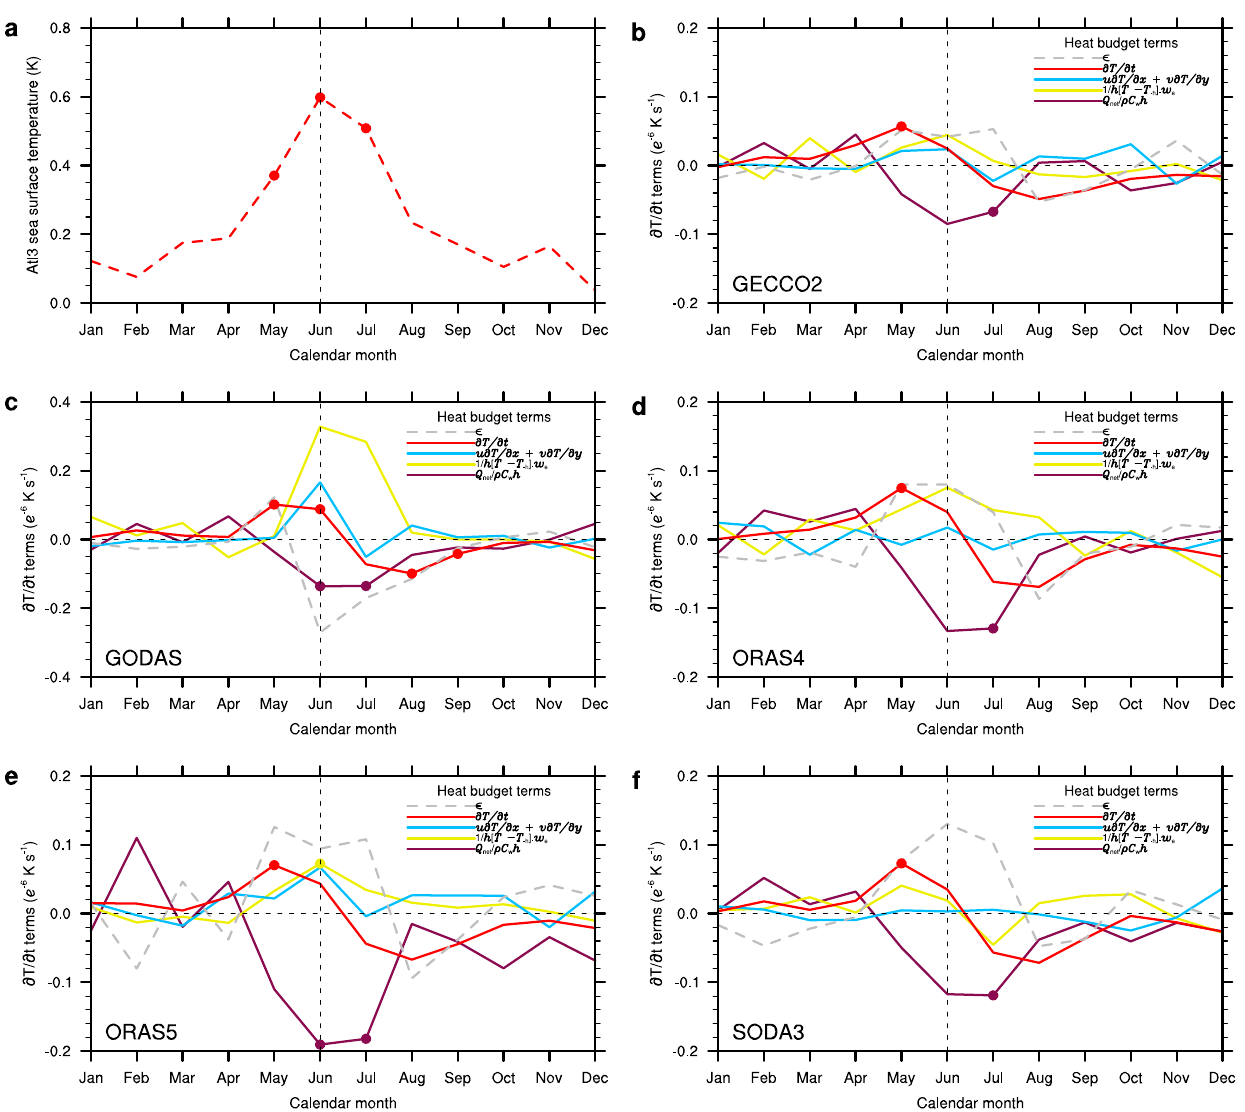
Fig. 5 Composites of the Atlantic Niño heat budget. a Composite average of 10 Atlantic Niño events, de fi ned as Atl3 SST index (that is, average in the region 3°N – 3°S, 0° – 20°W) greater than or equal to 0.5 K persisting for two overlapping three-month seasons, for the period 1984 – 2009 (see “ Methods ” ). b – f Composite average of the ocean-mixed-layer heat budget terms for the 10 Atlantic Niño events in the different ocean reanalysis data sets indicated on the bottom-left corner of each panel. The heat budget terms shown are the time derivative of the temperature ( ∂ T / ∂ t) and the tendencies due to the surface net heat fl ux ( Q net / ρ C w h ), advective transport ( u ∂ T / ∂ x + v ∂ T / ∂ y ), entrainment (1/ h [ T − T - h ] w e ) and unresolved processes ( ϵ ). Dots denote statistical signi fi cance at the 95% con fi dence level. For all terms, positive (negative) values mean heating (cooling) of the ocean-mixed-layer. Note that the vertical scale for GODAS data set is twice as